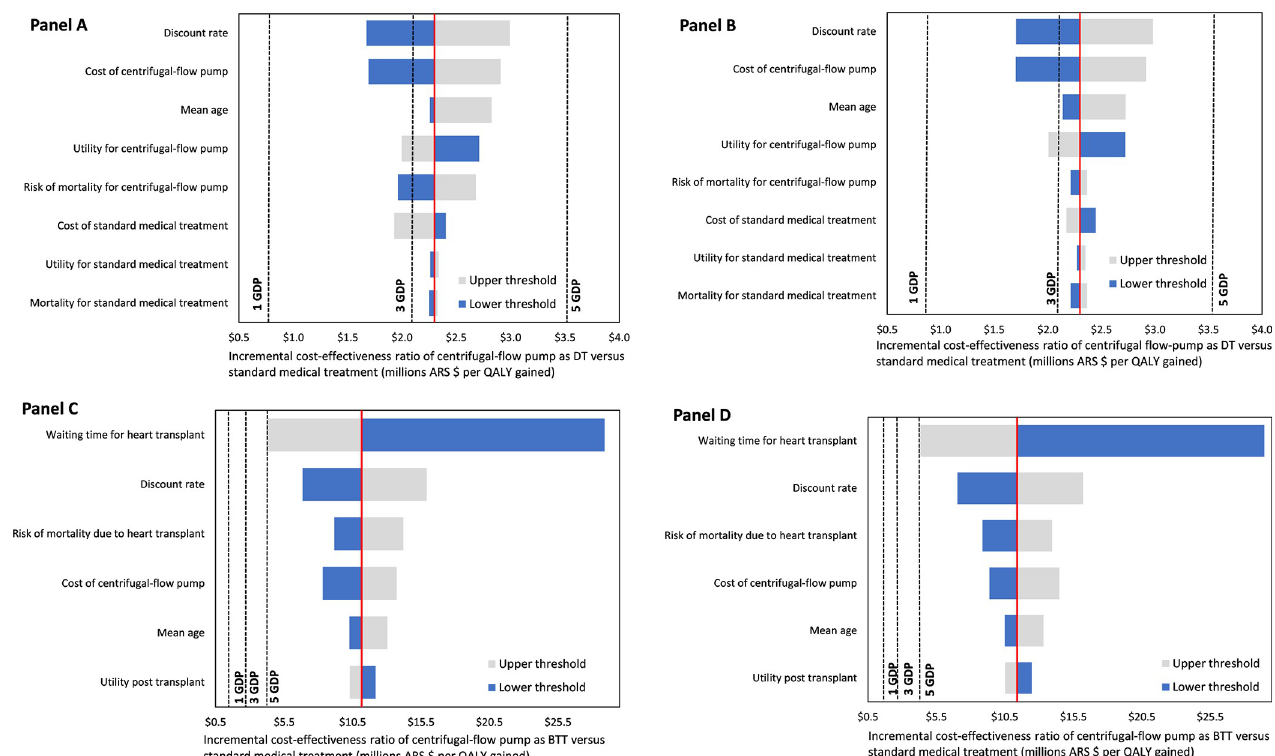
Fig 2. Tornado diagram: Series of n-way sensitivity analysis of the centrifugal-flow pump as destination therapy (DT) or bridge-to-transplant (BTT). For Model 1 (DT), results are reported in Panels A and B for the Social Security and Private Sector perspectives, respectively. For Model 2 (BTT), results are reported in Panels A and B for the Social Security and Private Sector perspectives, respectively. Notes. The bars indicate the range of ARS $ per QALY obtained with the centrifugal-flow pump as DT or BTT compared to standard medical management via 1-way sensitivity analyses of the input parameters across the range of values. The solid red line represents the base case cost-effectiveness result of ARS $ 2,299,352 per QALY gained for the Social Security perspective and ARS $ 2,309,937 for the Private Sector perspective. Exchange rate USD 1 = ARS 59.95.